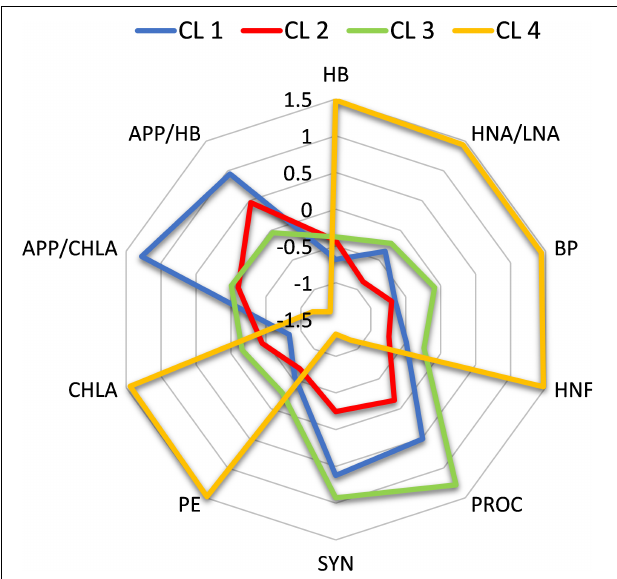
FIGURE 5 | Microbial food web structures in individual clusters. Values are standardized as z-scores.